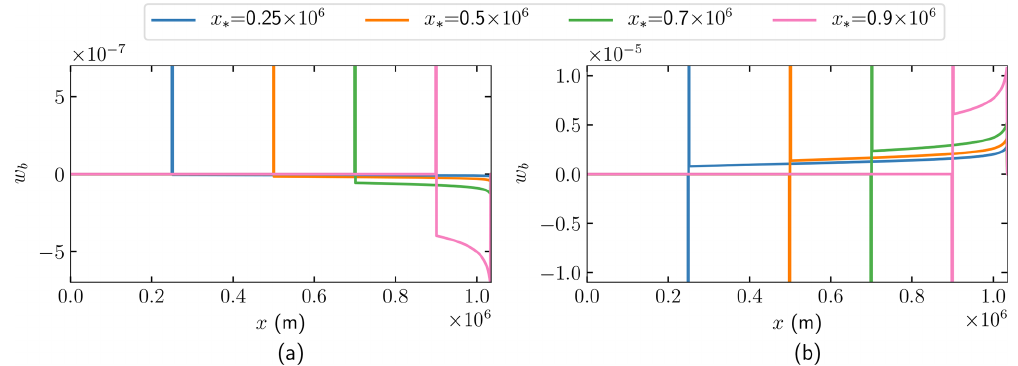
Figure 7. The analytical solution of weights w b = ψ x u + v x ηu x + vρgh x on δb in (38) for (a) u and (b) h observed at x ∗ = 0 . 25 × 10 6 , 0 . 5 × 10 6 , 0 . 7 × 10 6 , and 0 . 9 × 10 6